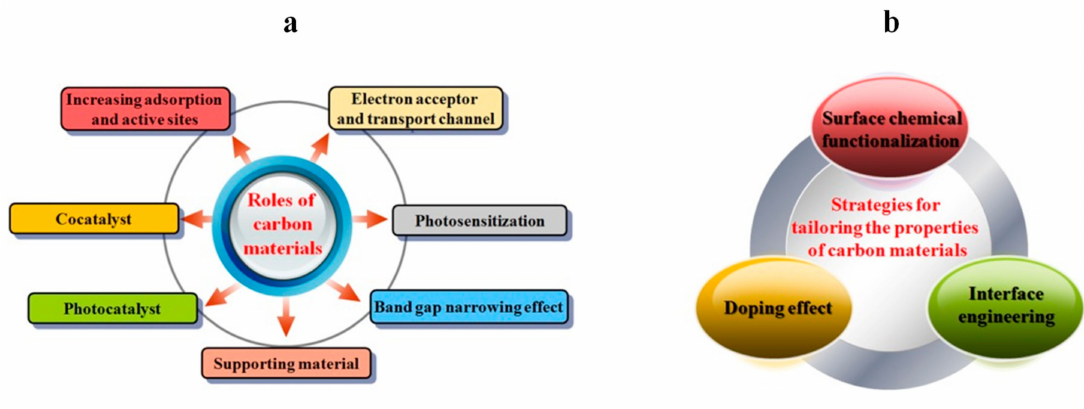
Figure 8. Main roles of carbon-based materials ( a ) and fundamental strategies for tailoring their photocatalyticproperties( b ). Adaptedandreprintedwithpermissionfrom[160],